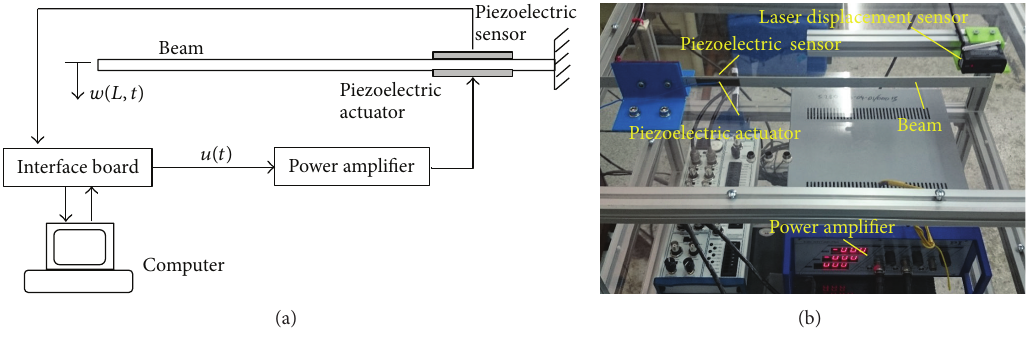
Figure 3: Experimental system: (a) schematic and (b) photograph.